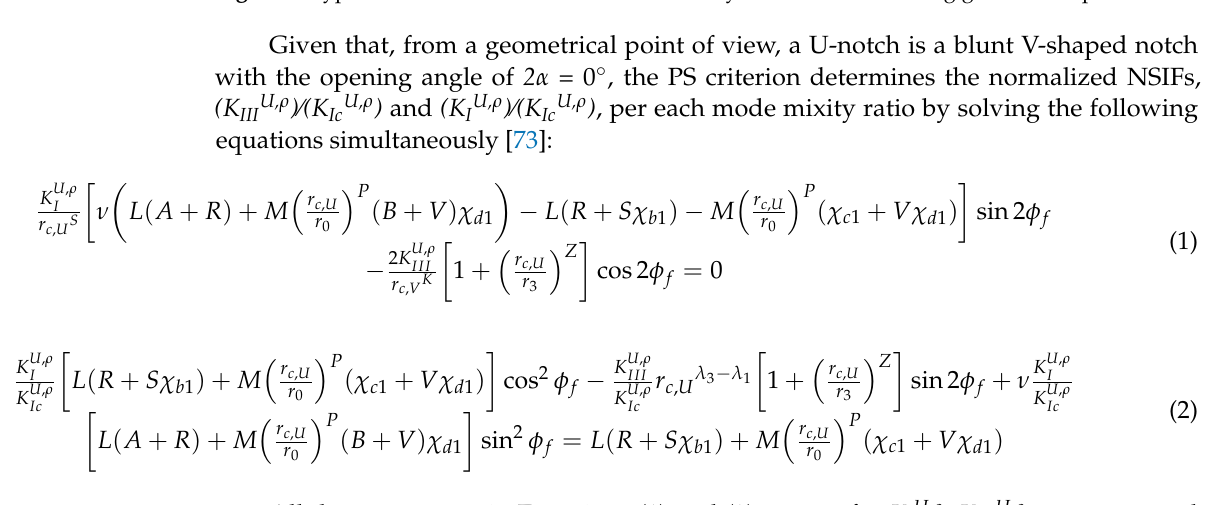
All the parameters in Equations (1) and (2), except for K IU, ρ , K IIIU, ρ , r 0 , r c,U , υ , and φ f , are constant coefficients which depend on the notch opening angle, and have been introduced in reference [73]. The out-of-plane fracture angle φ f varies from 0 in mode I conditions up to π /4 in mode III loading conditions [73]. R c,U , as the critical radial distance from the origin of the notch polar coordinate system, is derived from Equation (3), in which r c is the critical distance measured from the notch tip and r 0 is the distance between the notch tip and the origin of the coordinate systems. Note that the expression of r 0 for U-notches is simply r 0 = ρ / 2 , where ρ denotes the notch tip